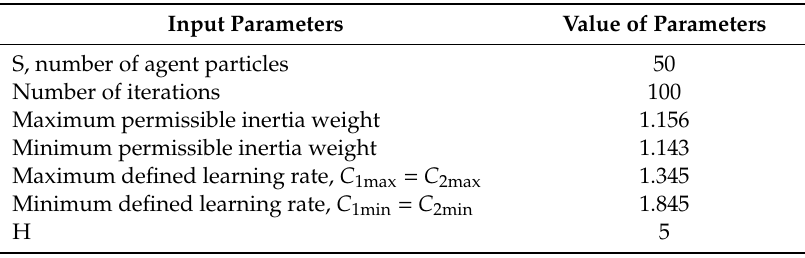
Table 8. Initial parameters of